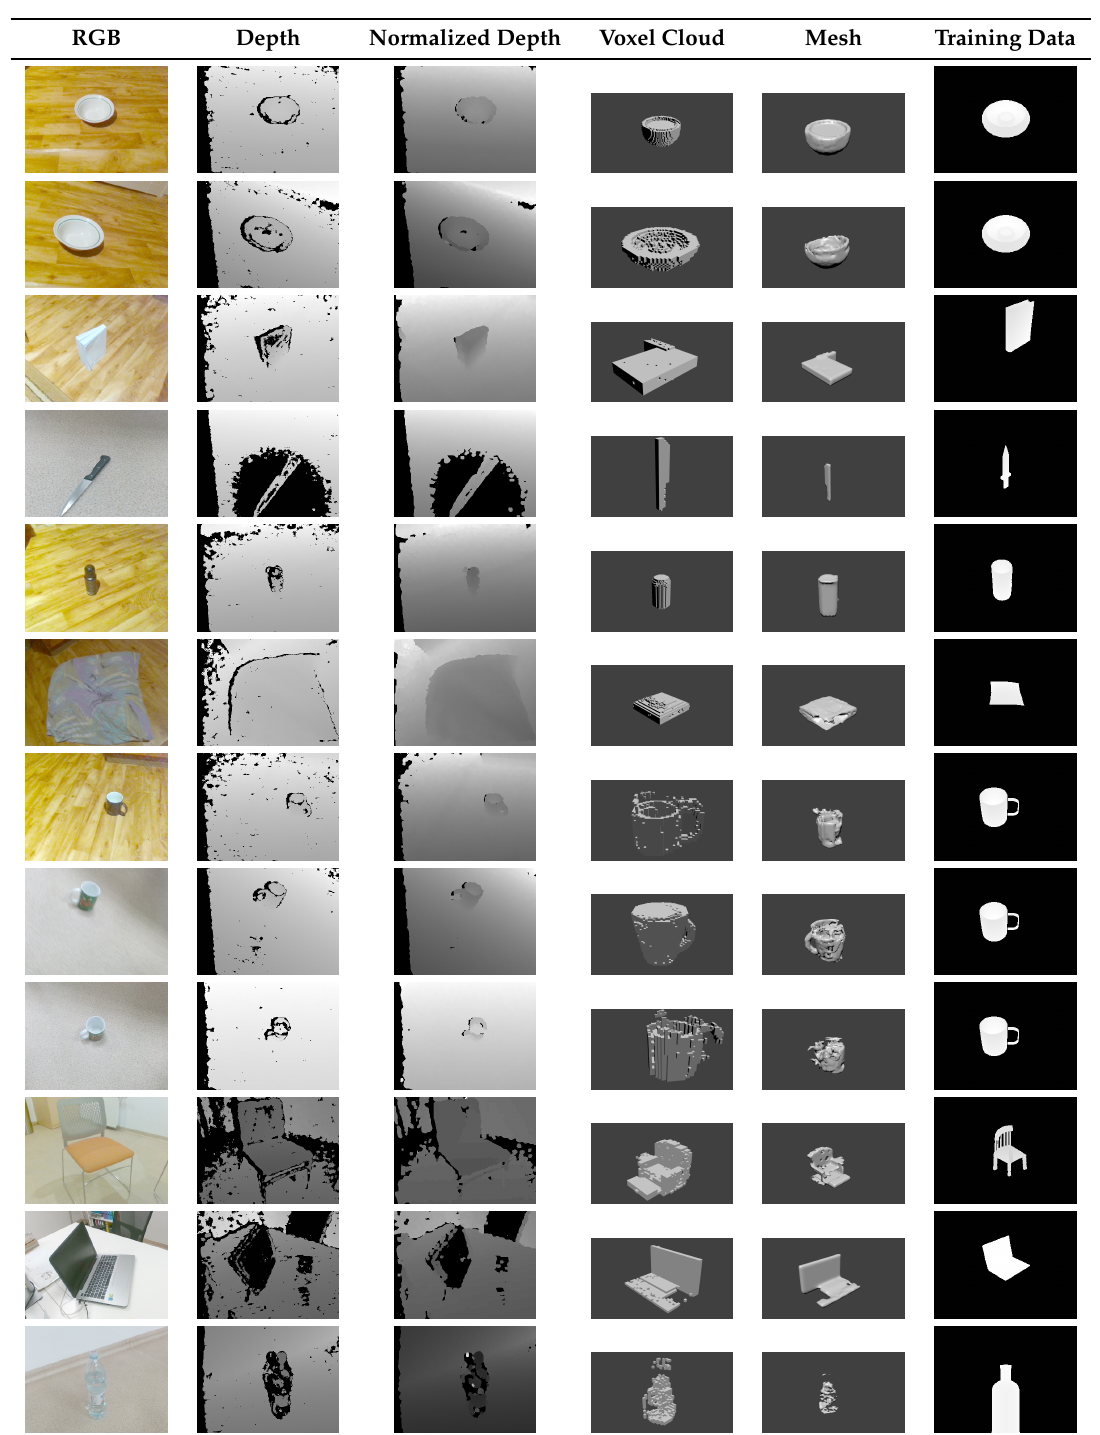
Table 3. Visual qualitative reconstruction results. Table shows: RGB frame, infrared (depth) frame, normalized depth frame; reconstructed voxel cloud; polygonized and smoothed voxel cloud; an example of a similar object in training